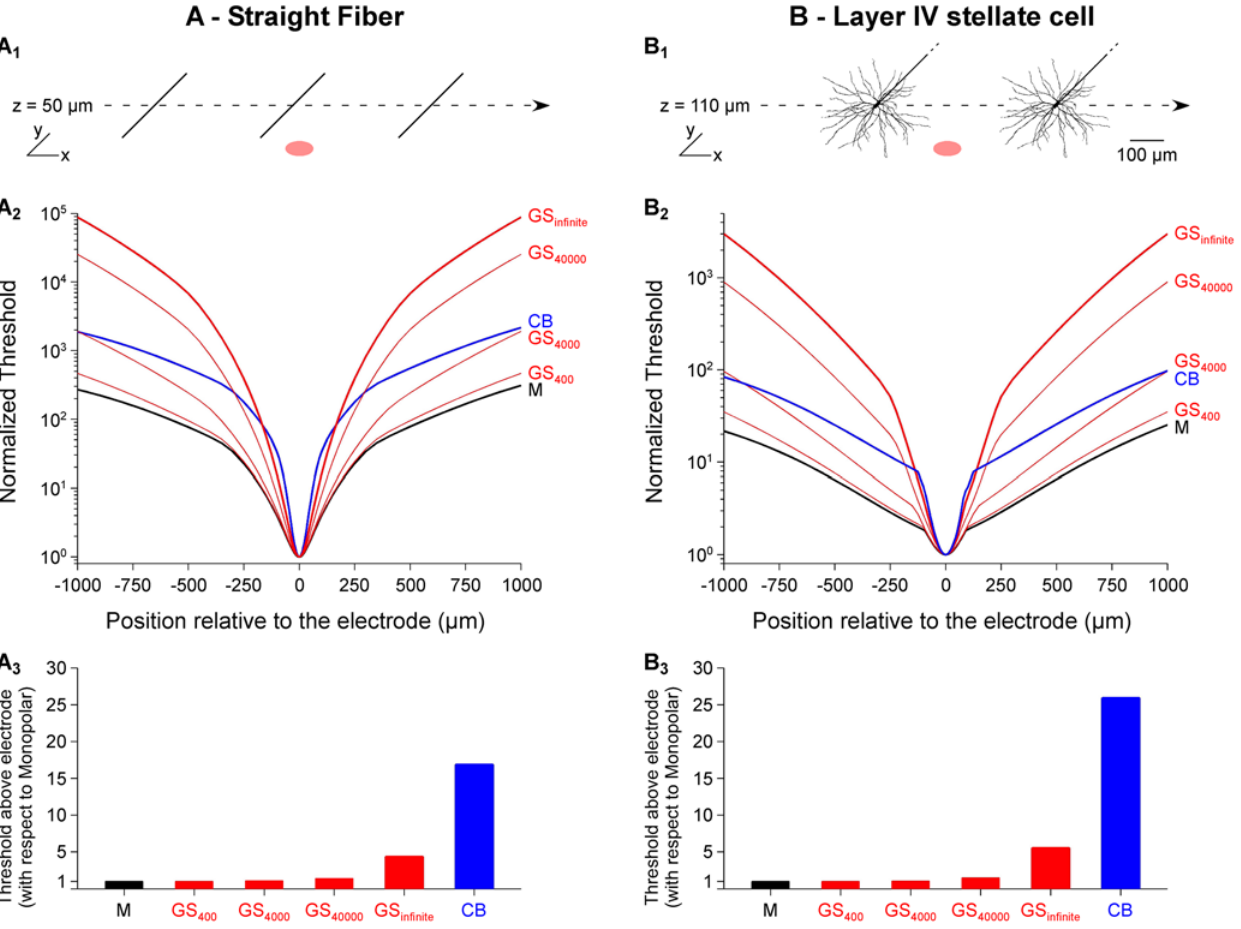
Figure 9. Improvement of the focality of threshold-distance curves with a ground surface configuration. Current thresholds required to activate a straight fiber ( A1 ) or a cortical stellate cell ( B1 ) were determined along a line passing over the electrodes, and normalized by the minimum threshold value along the line, for each configuration. A2 and B2 : Normalized thresholds for all electrode configurations. A3 and B3 : Thresholds above electrode for all configurations, normalized with respect to that obtained for monopolar stimulation (94.1 m A for the fiber, 436 m A for the stellate cell). This normalization allows comparing directly the factor by which stimulation current should be increased with respect to the monopolar case for the different electrode configurations. It clearly appears that the CB requires much stronger currents than the ground surface